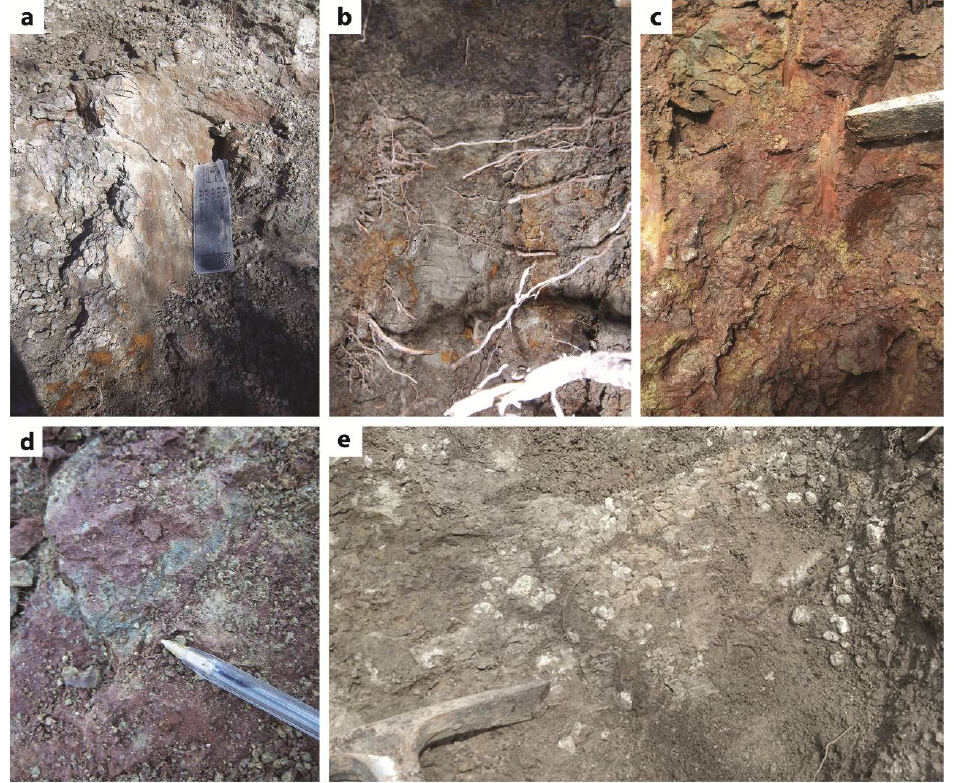
Figure 6. Pedogenic features observed in the field. ( a ) Large, exposed slickenside surface (16 × 25 cm) in Section 1 within Unit 1; ( b ) Green-grey color (gley) of the mudstone of Unit 2 in Section 1; ( c ) Angular blocky texture of Unit 1 in Section 1 with green and yellow mottles; ( d ) Drab colored mottle present in the upper portion of Unit 1 in Section 1; ( e ) Horizon of carbonate nodules weathering out of Unit 2 in Section